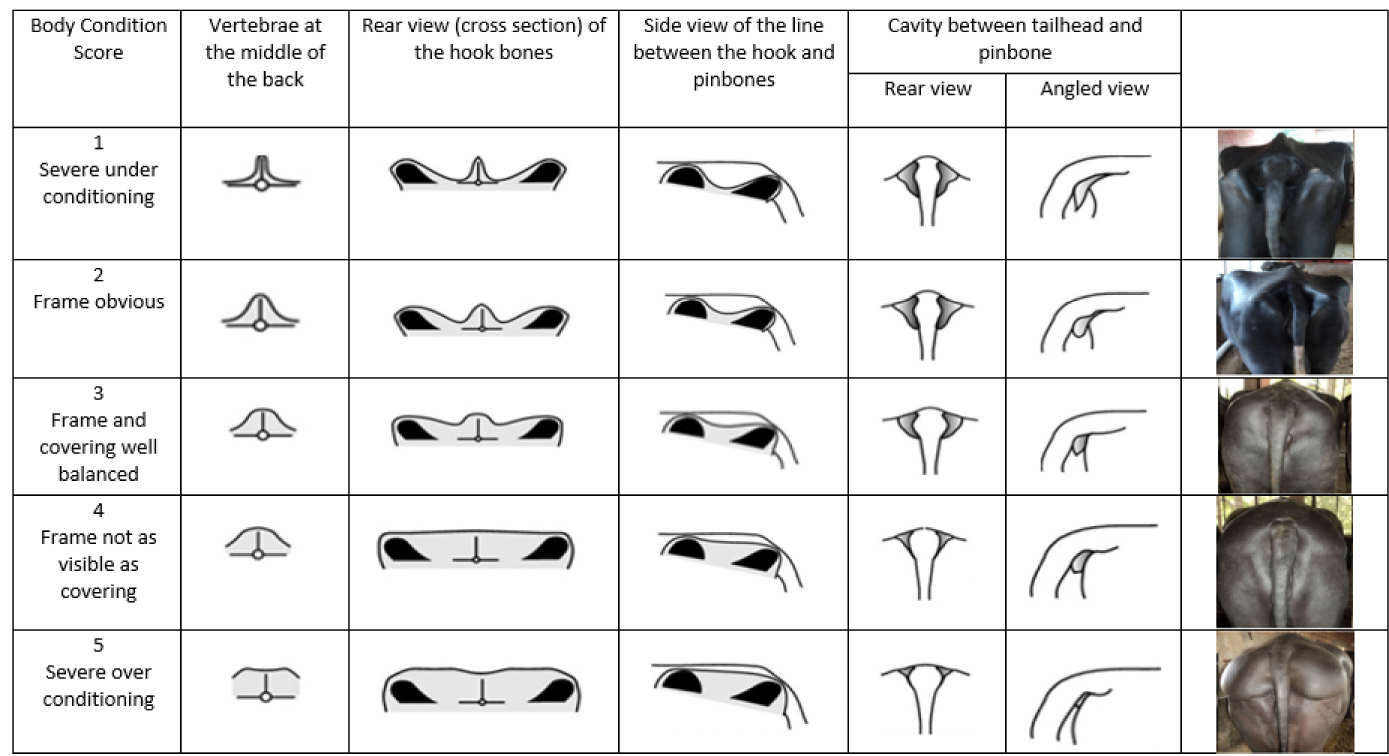
Figure 4. Body condition scoring chart for buffalo in a scale using 1.0 increments. Reprinted with permission from ref. [87]. Copyright 2017 Singh et